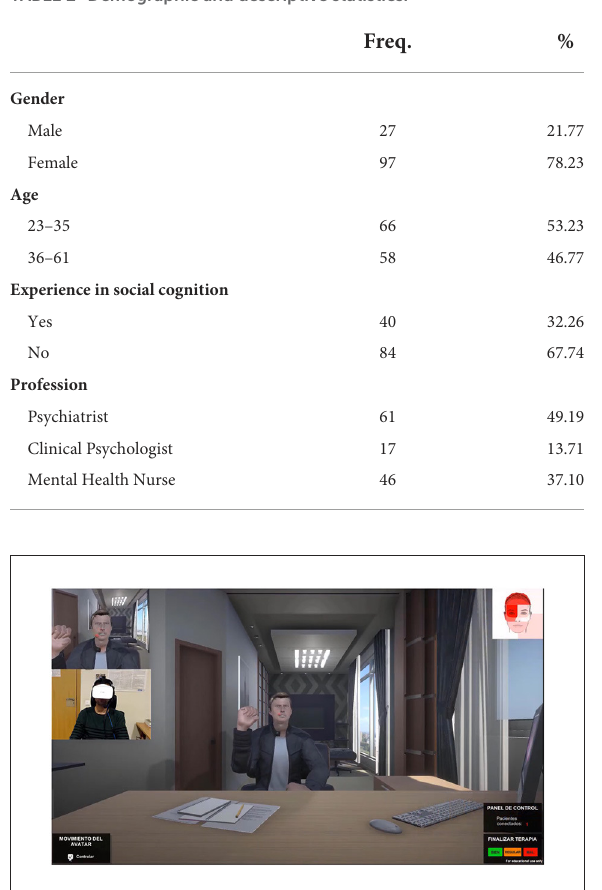
FIGURE1 User interface of the tool shown to the therapists participating in the